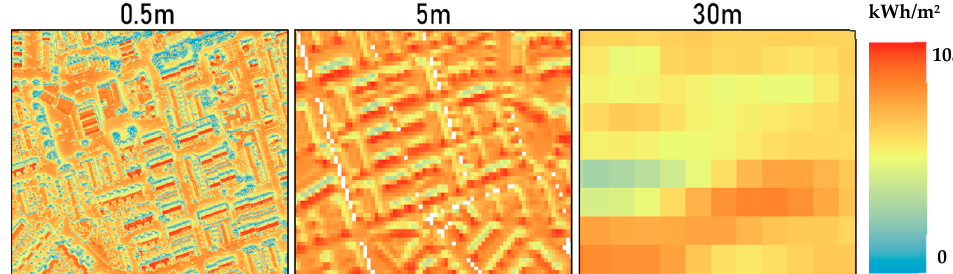
Figure 10. Solar Radiation with varying spatial resolution run with the default model in ArcGIS.